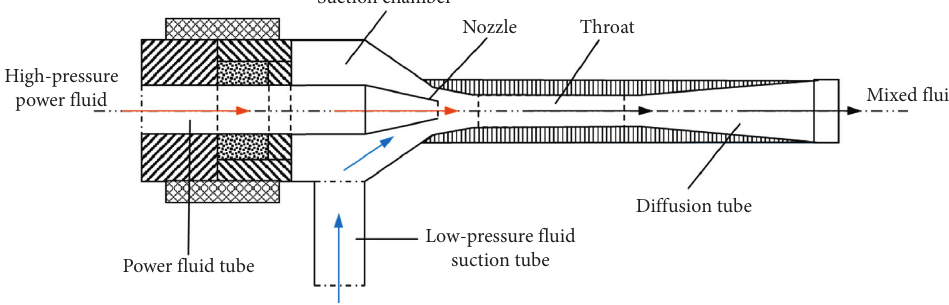
Figure 4: Working principle of the jet pump.